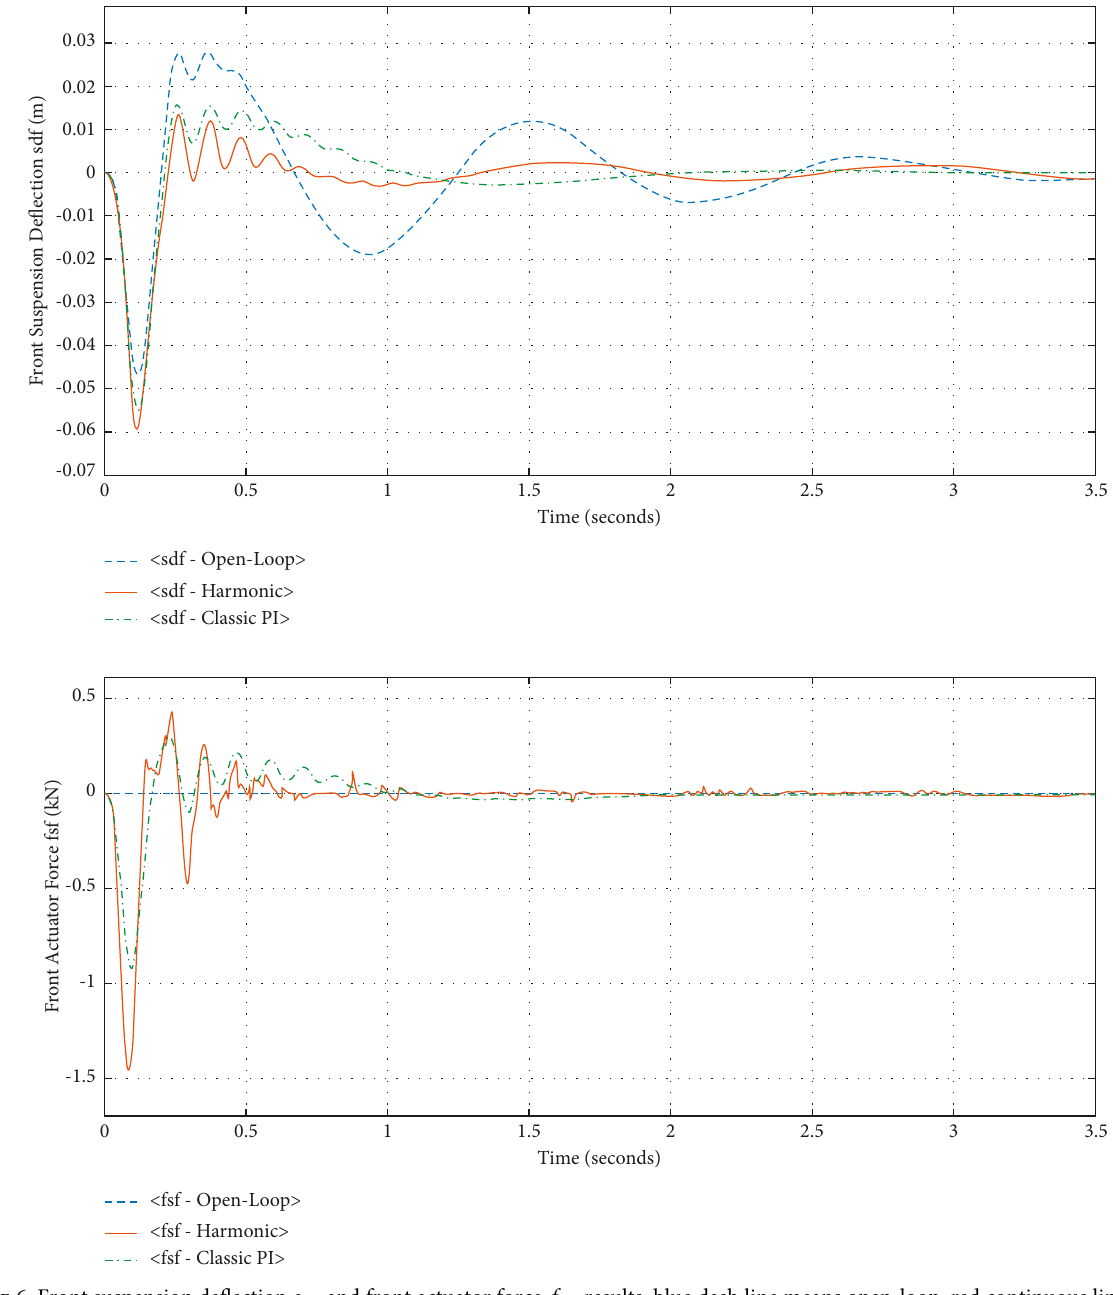
f df and front actuator force sf results: blue dash line means open-loop, red continuous line means